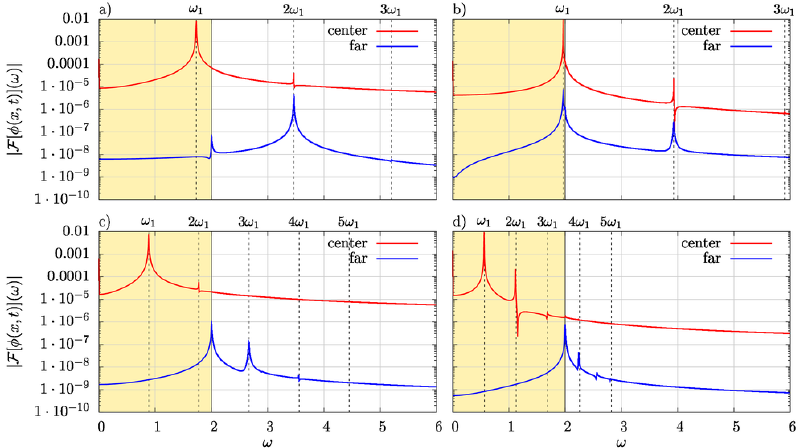
Figure 14 . Power spectra of the measured at the center x = 0 (red) and far x = 200 (cid:12)eld (blue) for di(cid:11)erent values of the potential depth V 0 and for initial excitation of the oscillational mode A = 0 : 01. Four di(cid:11)erent scenarios correspond to a) V 0 = 2 : 0 - almost pure second harmonic, b) V 0 = 0 : 5 - large contamination of the near-the-threshold modes, c) V 0 = 5 : 0 - decay through the third harmonic, d) V 0 = 5 : 6 - decay through the fourth